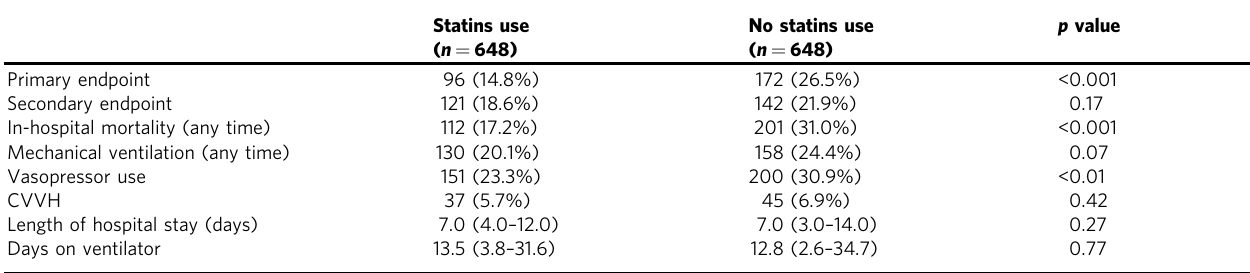
Table 3 Clinical outcomes in the propensity-matched cohort of patients hospitalized with